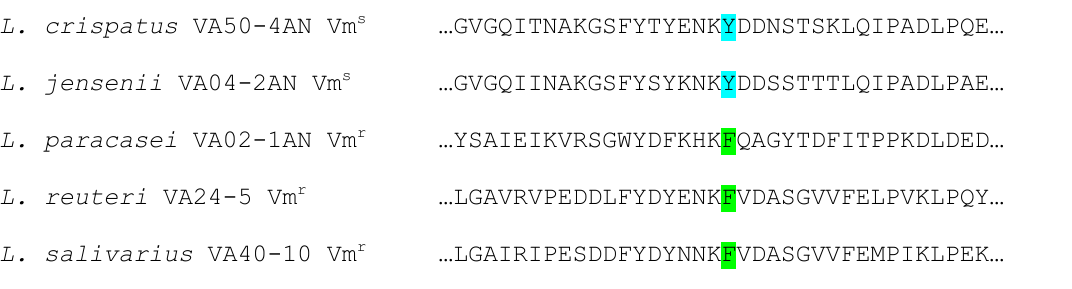
Figure 2. Alignment of amino acid sequences around the active site of D-Ala-D-Ala ligases of the five Lactobacillus spp. strains sequenced. Strains with phenylalanine (F) at the enzyme active site (green) show a vancomycin-resistant phenotype, while those having a tyrosine (Y) (pale blue) display a vancomycin-susceptible phenotype.